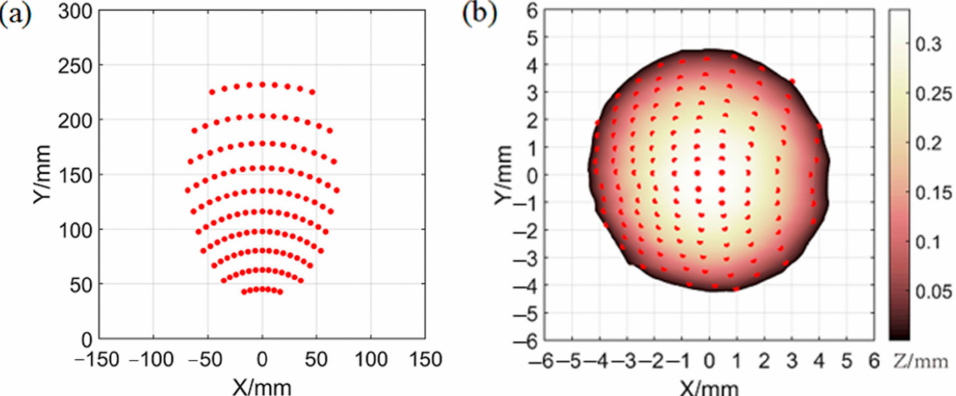
Figure 12. The reflection image reflected by a simulation surface and its reconstructed surface. ( a ) The reflection image (no missing points, multiple points); ( b ) the simulated surface (no missing points, multiple